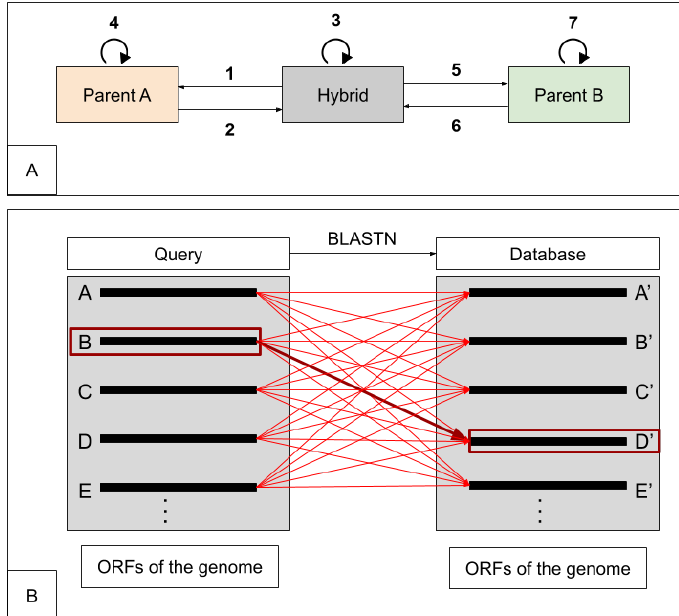
Figure 4. ( A ): The hybrid genome is blasted against the parental genomes (line 1 and 5) and reciprocally (line 2 and 6) to identify the orthologs. Each genome is searched against itself (line 3, 4, and 7) in order to get the best paralogs when they exist. ( B ): each ORF of the query genome is blasted against the database genome (red lines). When two ORFs are shown as reciprocal best hit (bold red arrows), the so called “best bidirectional hit” is identified. For example, ORF B (boxed in red) of the hybrid has as best hit the ORF D’ (boxed in red) of the parent A and vice versa.